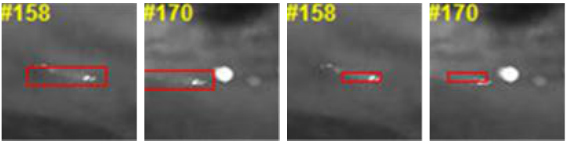
Figure 13. Visualization of the tracking results between the ECOOL tracker and KCFOL